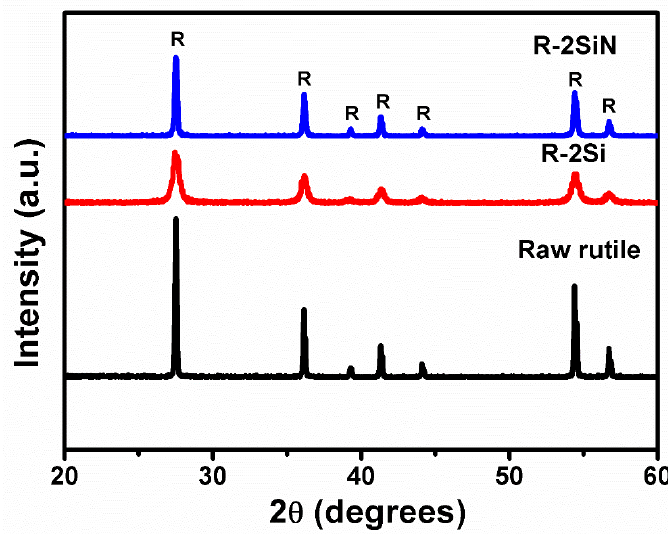
Figure 4. X-ray diffractograms of the rutile-containing samples.